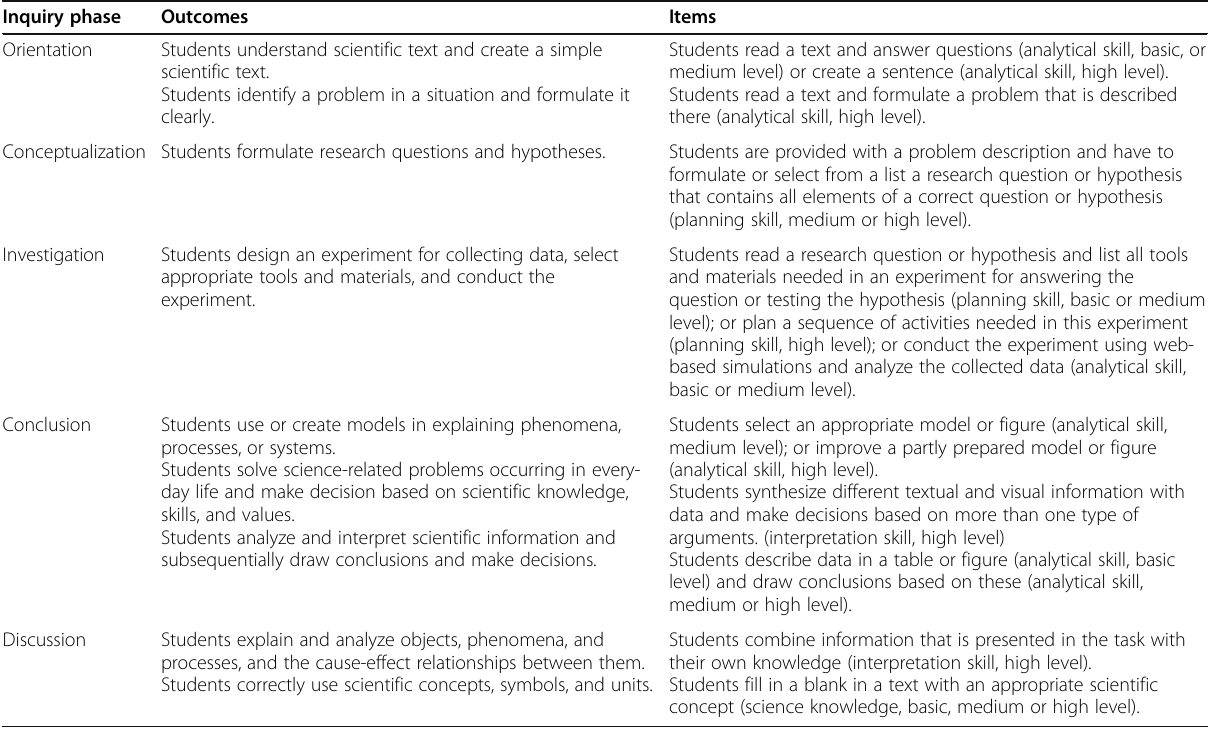
Table 2 Learning outcomes assessed with the SIT-PE test Inquiry phase Outcomes Items Orientation